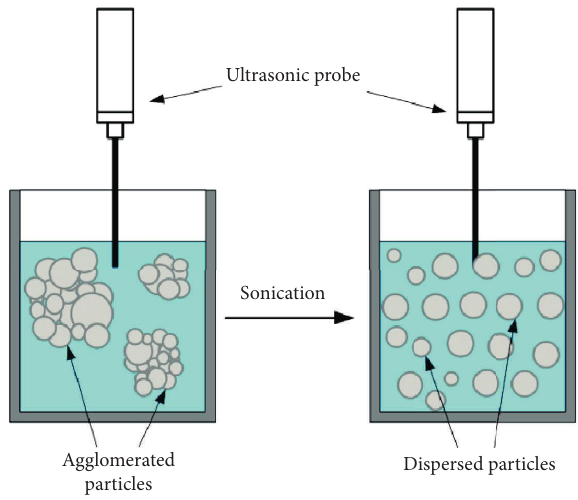
Figure 1: Ultrasonication